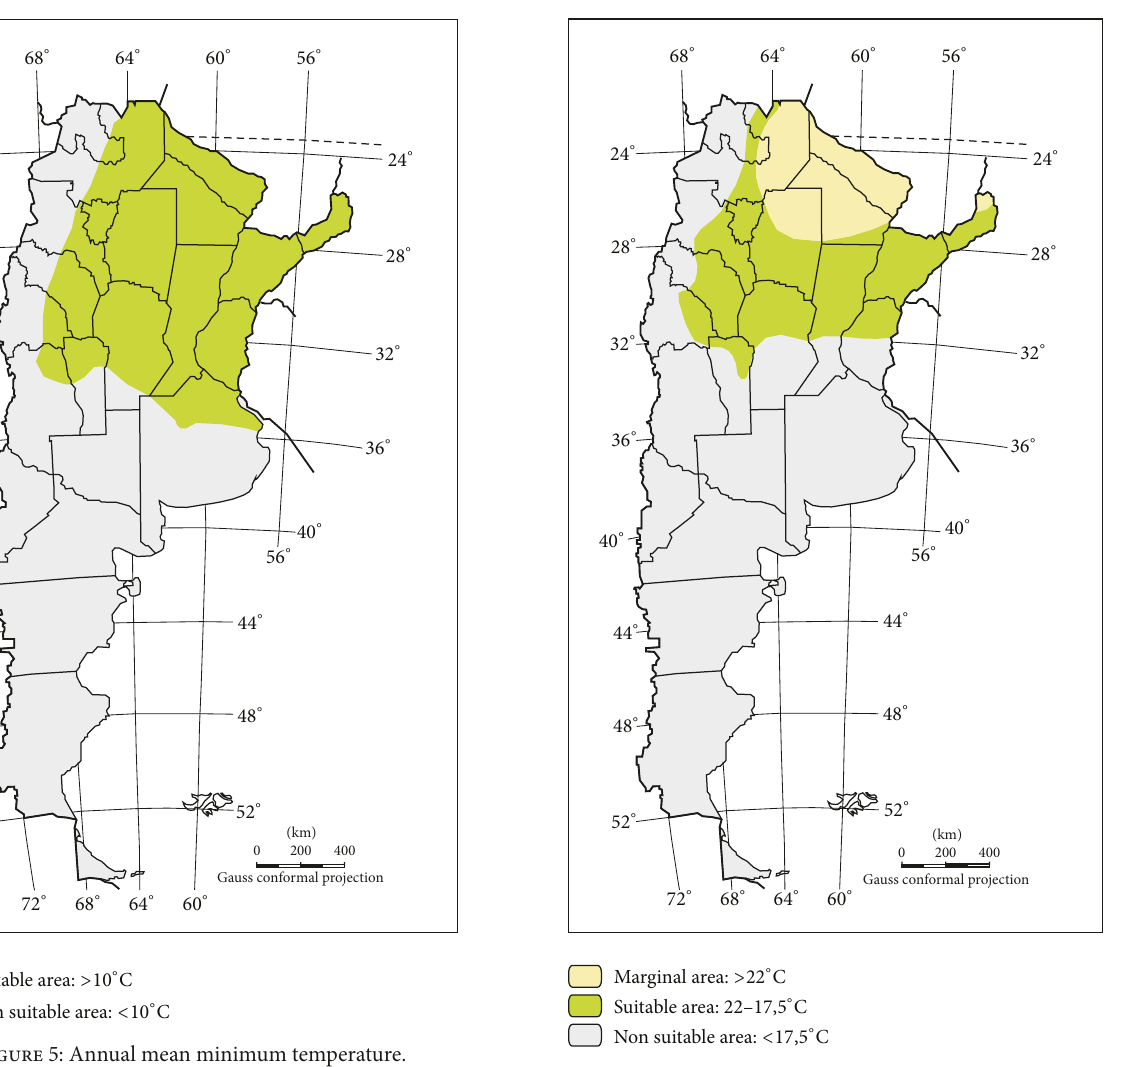
Figure 6: Winter mean maximum